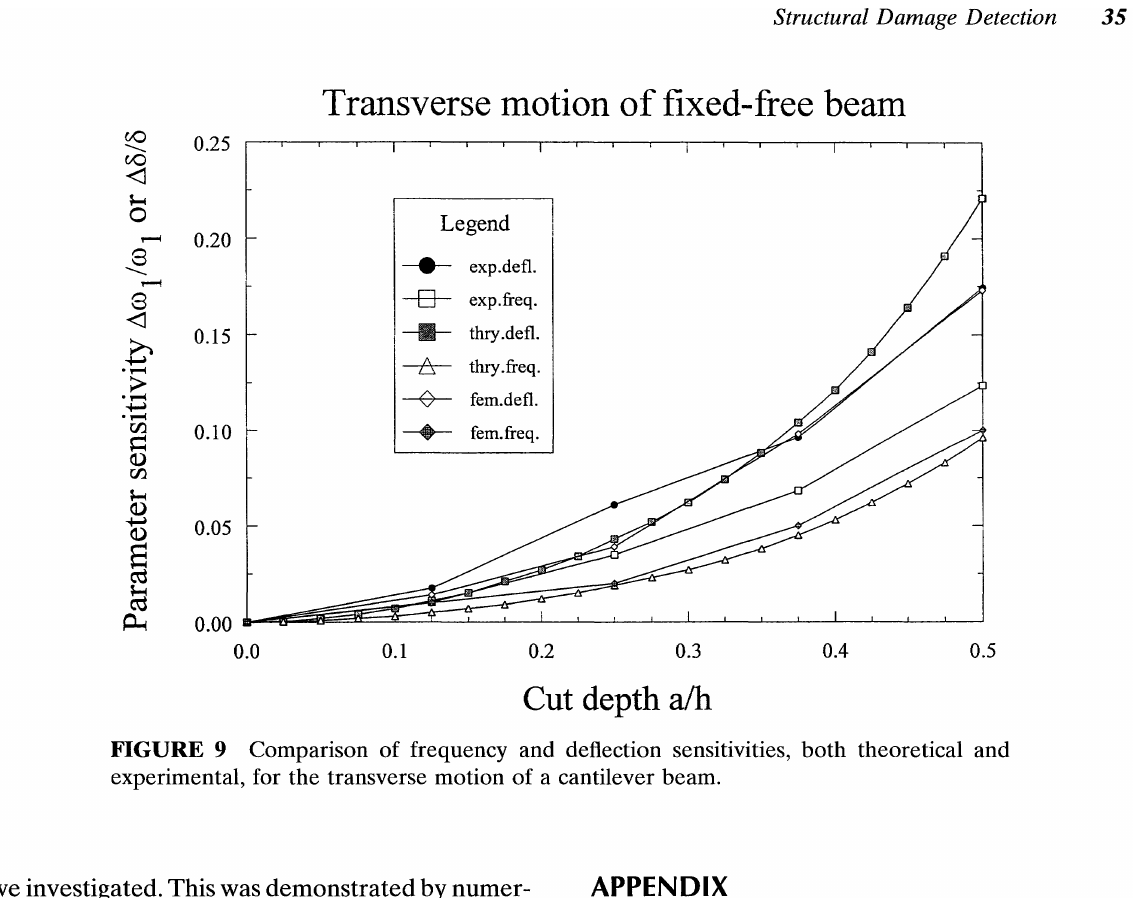
FIGURE 9 Comparison of frequency and deflection sensitivities, both theoretical and experimental, for the transverse motion of a cantilever beam.